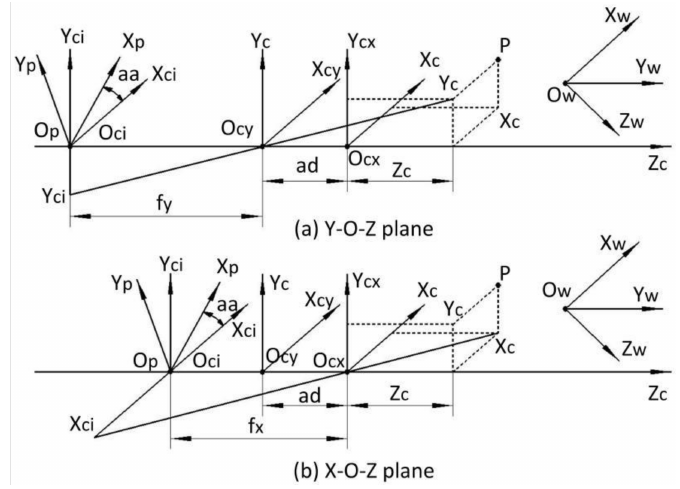
Figure 1. Anamorphic imaging model. ( a ) Imaging rays in the Y c -O cy -Z c plane; ( b ) imaging rays in the X c -O cx -Z c